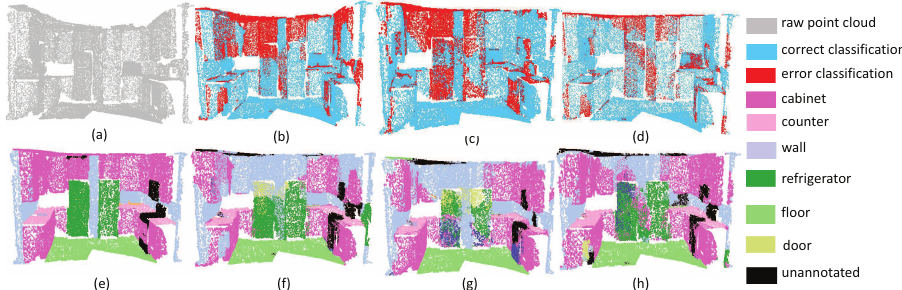
Figure 5. The plane segmentation results on Kitchen . ( a ) input, ( e ) ground truth, ( b , f ) the classification result by PointNet++, ( c , g ) the classification result by PointSIFT, and ( d , h ) the classification result by SAN.